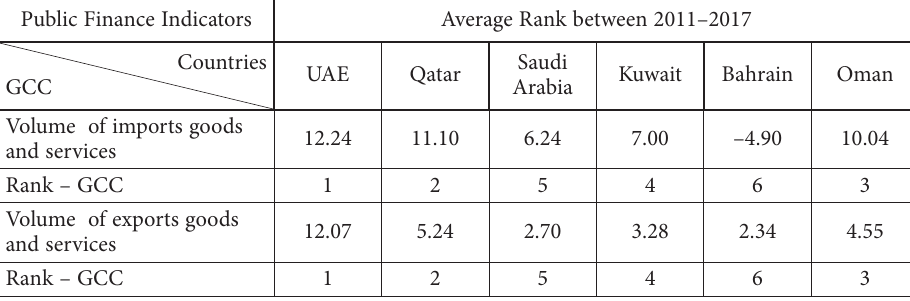
Table 5. Trade indicators of GCC countries and rank (source: International Monetary Fund, World Economic Outlook Database (2018) From 2011–2017. Source of Rank: author) Average Rank between 2011–2017Public Finance